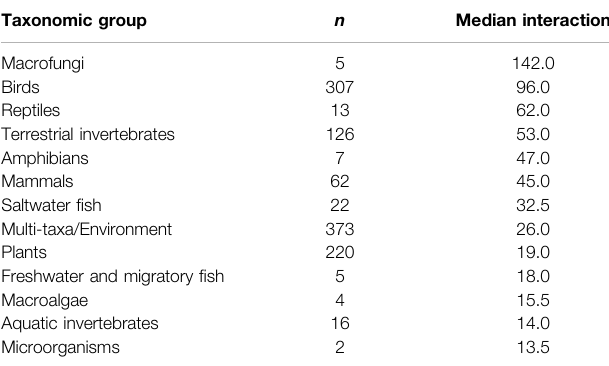
TABLE 5 | Number of Facebook posts focusing on different taxonomic groups and their respective obtained engagement. Taxonomic